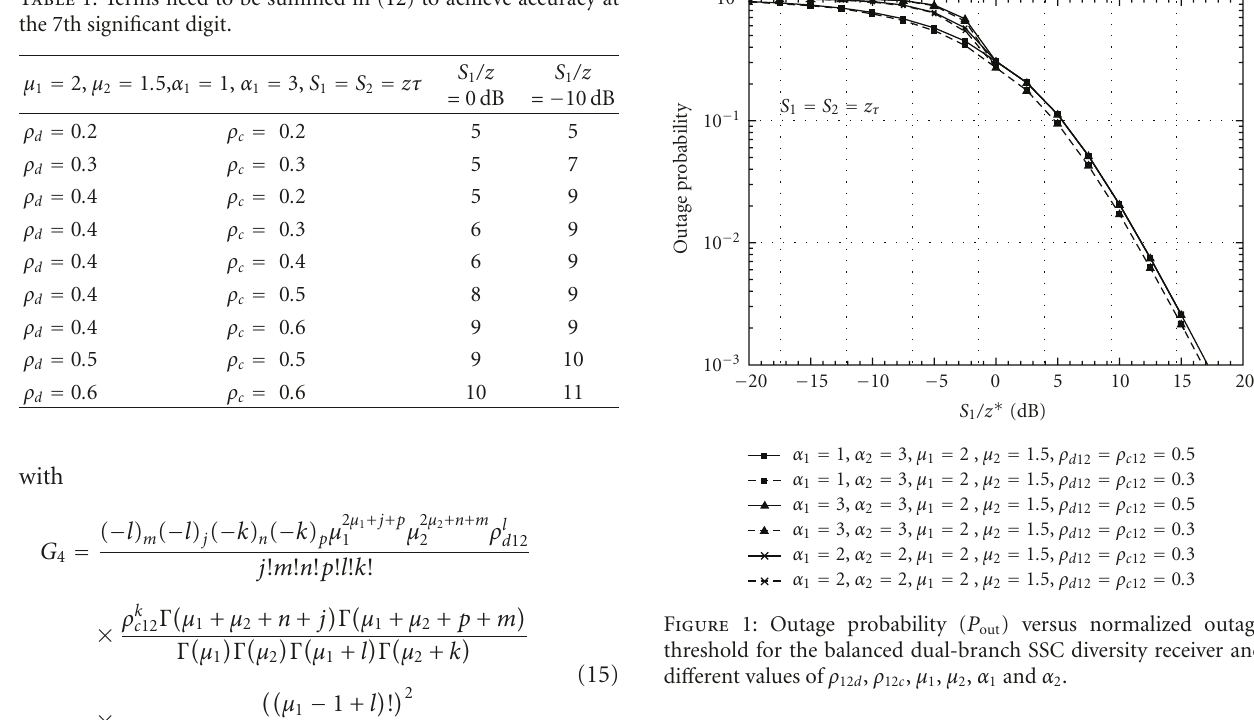
function of the normalized outage threshold (dB) for several values of ρ d 12 , ρ c 12 , μ 1 , μ 2 , α 1 , and α 2 . Normalized outage threshold (dB) is defined as being the average SIR’s at the input branch of the balanced dual-branch switched-and- stay combiner, normalized by specified threshold value z ∗